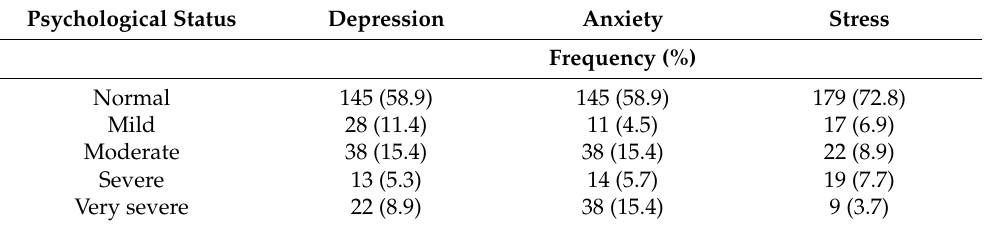
Table 3. Level of depression, anxiety, and stress (DASS-21) among university students ( n = 246). Psychological Status